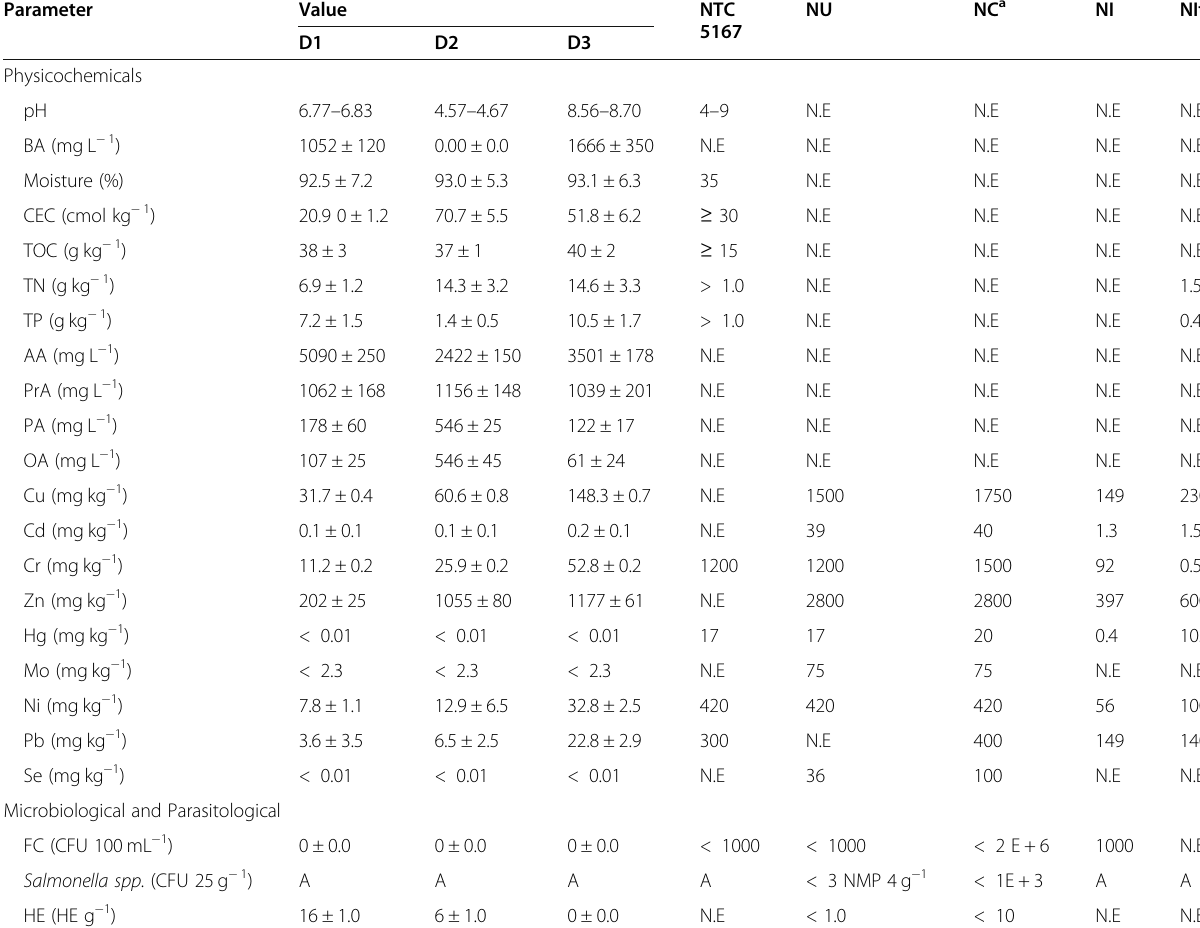
Table 1 Physicochemical, microbiological, and parasitological characterization of digestates